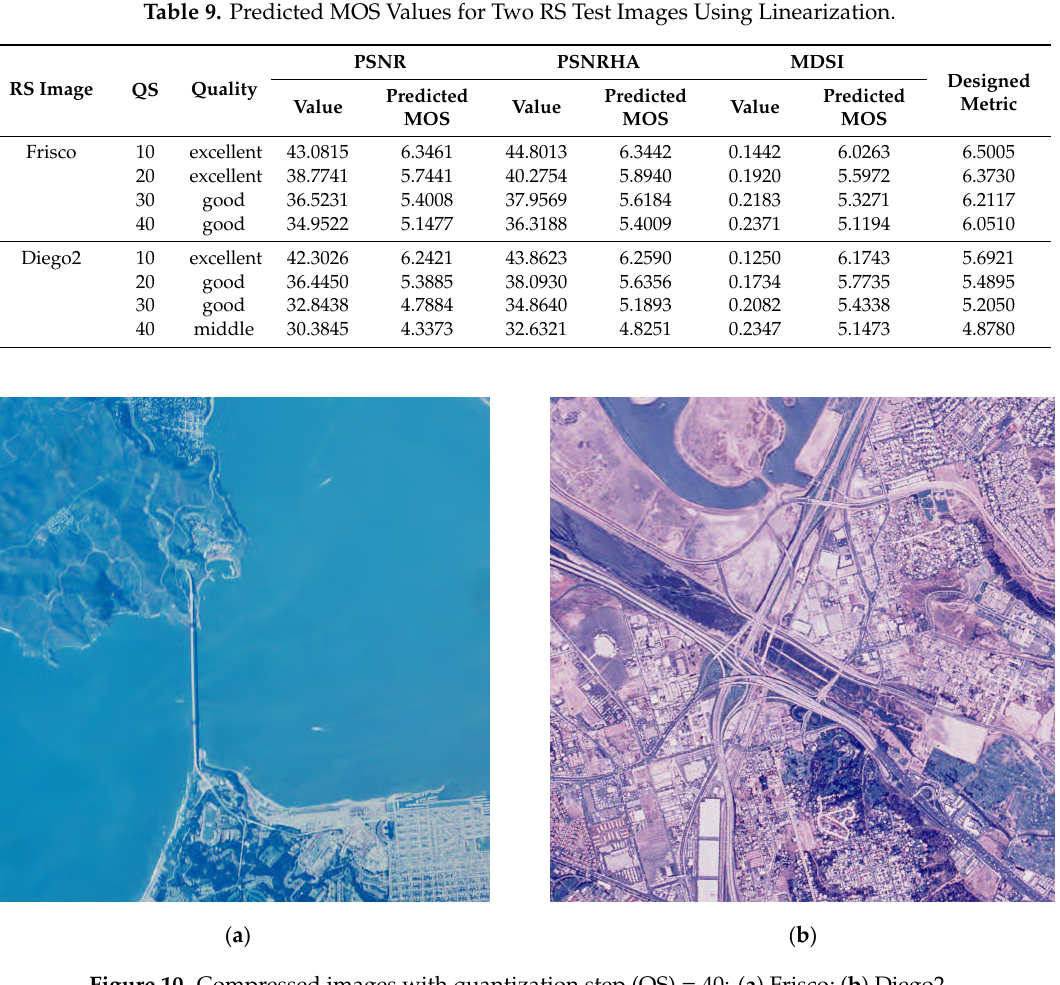
Table 10. Predicted MOS values for four RS test images distorted by an additive white Gaussian noise.